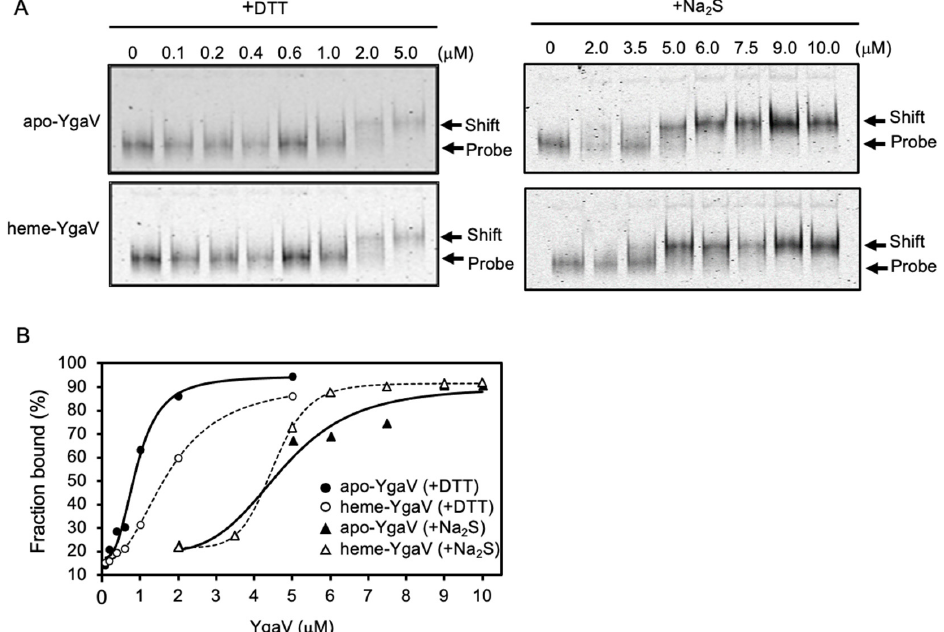
Figure 5. DNA ‐ binding characteristics of YgaV: ( A ) Gel mobility shift analysis of DTT ‐ and Na 2 S ‐ treated apo ‐ and heme ‐ reconstituted YgaV to the ygaVP promoter DNA. The fluorescent ‐ labeled DNA probe (50 nM) was incubated with various concentrations of purified apo ‐ YgaV and Heme ‐ YgaV for 30 min at room temperature. Subsequently, proteins were pretreated with 1 mM DTT or 10 ‐ mM Na 2 S to be reduced and oxidized, respectively. Then, 5% PAGE was used to separate samples. After electrophoresis, gels were analyzed using an image analyzer; ( B ) Binding isotherms of DTT ‐ treated apo ‐ and heme ‐ reconstituted YgaV, and Na 2 S ‐ treated apo ‐ and heme ‐ reconstituted YgaV.